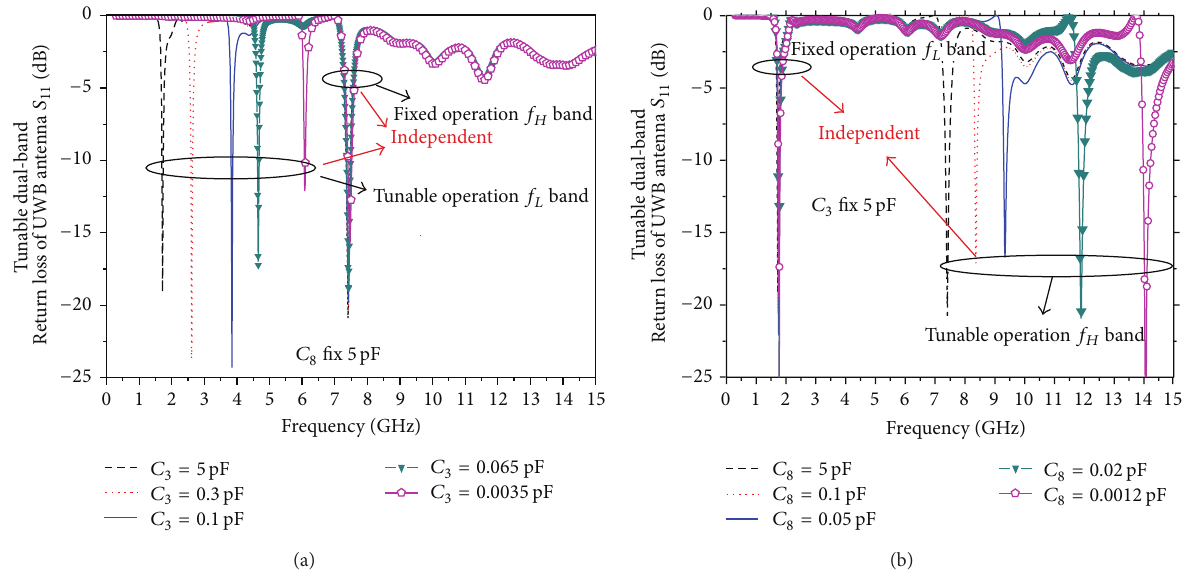
Figure 3: Simulation of independently tunable dual-band antennas at (a) 𝑓 𝐿 , (b) 𝑓 𝐻